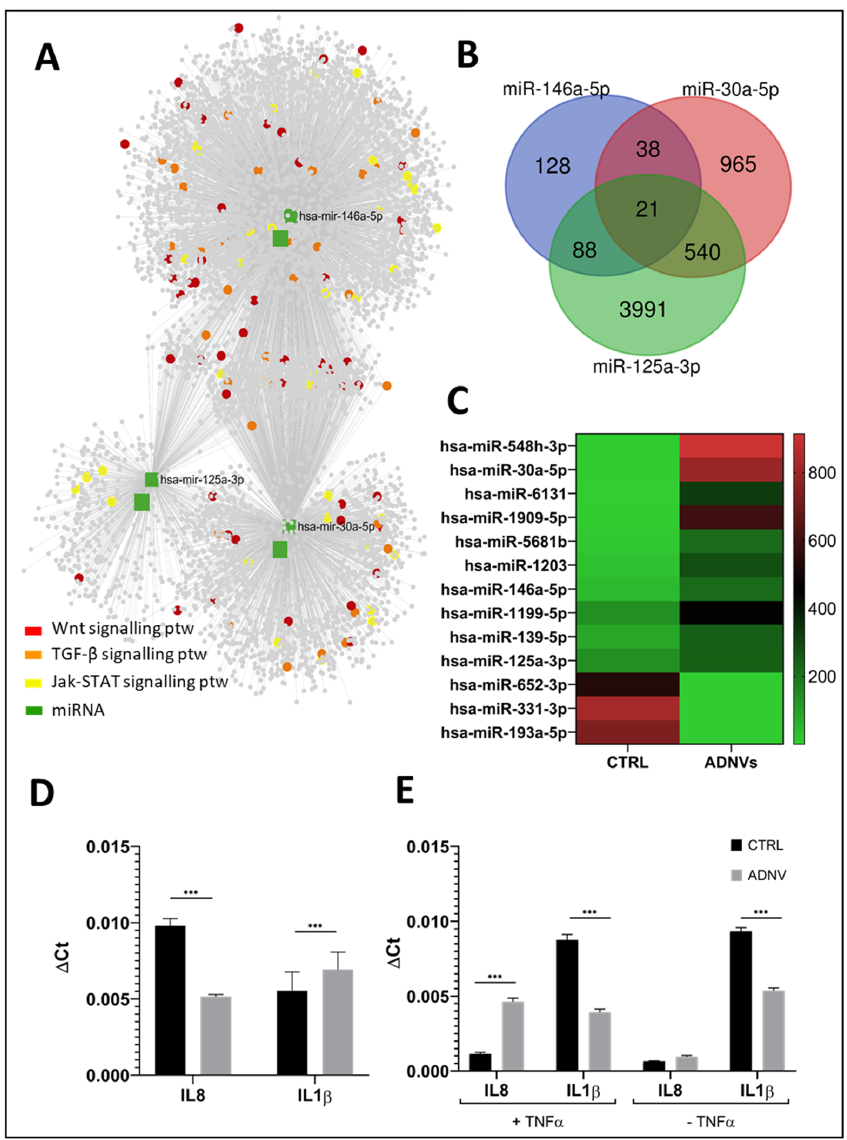
Figure 5. ( A , B ) Enrichment analysis of differentially expressed miRNAs with miRNet software. The first graph shows the network of miRNAs and their targeted genes; a few key elements are highlighted in different colors for different metabolic pathways in which they are involved. ( B ) Graph is instead a visualization of genes shared as targets by miR-146a-5p, miR-125a-3p, and miR-30a-5p. ( C ) Heatmap representation of statistically significant, differentially expressed miRNAs in THP-1 control samples and THP-1 incubated with the ADNVs fraction for 48 h, from less expressed (green) to more expressed (red) in both conditions. ( D , E ) The two graphs show expression values ( Δ Ct) results with RT-qPCR of IL-1b and IL-8 cytokines in THP-1 ( D ) and fibroblast with and without previous TNF α treatment ( E ). *** p < 0.001